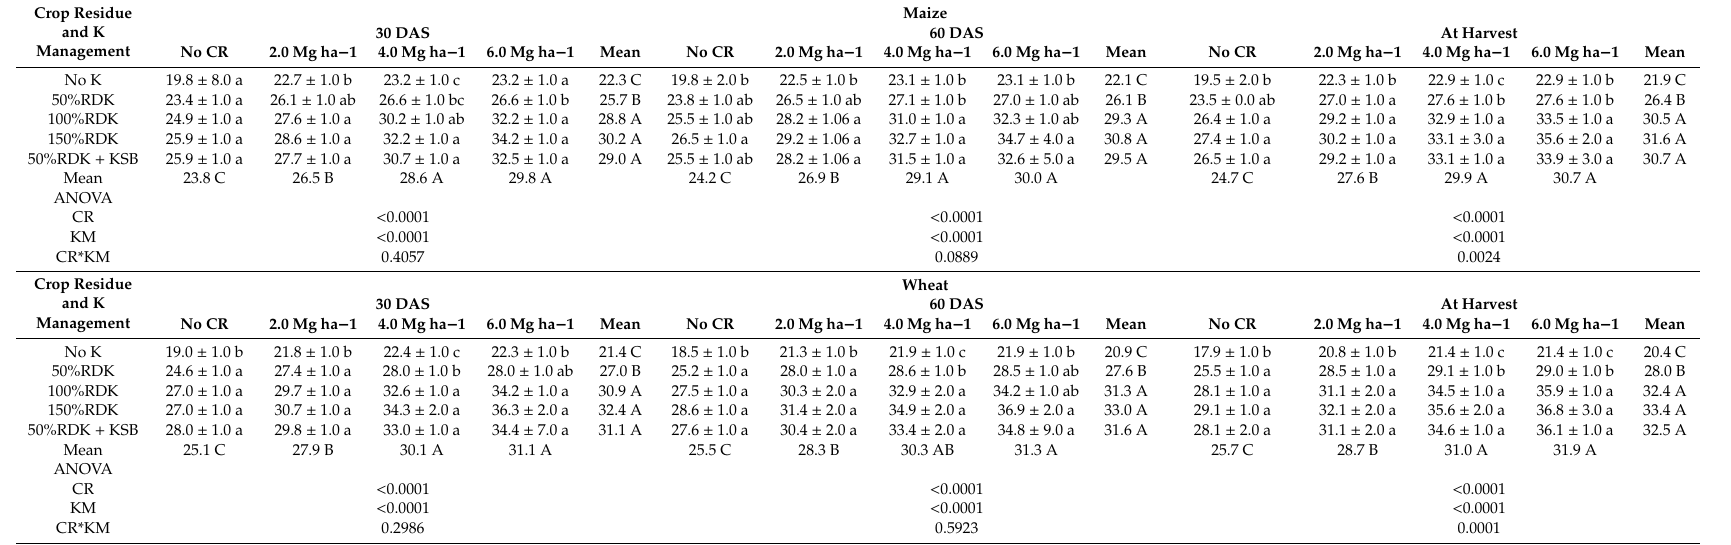
Table 3. Crop residue and potassium management practices on water soluble potassium (kg ha − 1 ) of maize and wheat soil at di ff erent crop growth stages under zero tillage maize–wheat system (pooled data of two